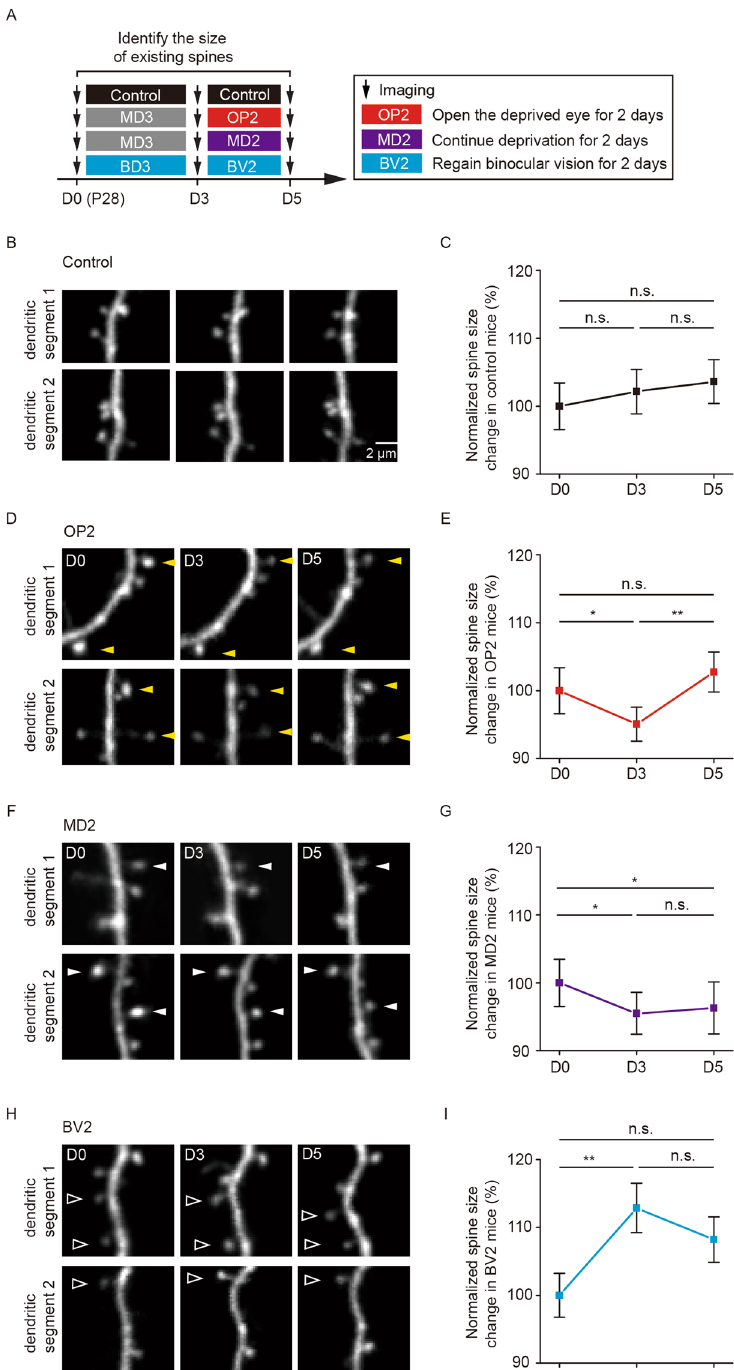
Figure 4. MD or BD-induced spine size changes tend to be reversed after binocular recovery. ( A ) Schematic of experimental design to evaluate the effect of visual deprivation and subsequent recovery on the size of dendritic spines in the binocular region of the primary visual cortex. ( B ) Images of dendritic spine size changes from day 0 to 5 in non-deprived control mice. Scale bar: 2 μ m. ( C ) Average spine size (measured by spine fluorescence relative to shaft fluorescence) exhibited no significant difference over 5 days in control mice (n = 116 spines from 6 mice). ( D ) Images of dendritic spine size changes from day 0 to 5 in OP2 mice. Yellow arrowheads indicate spines with size decrease after MD and size increase after subsequent binocular recovery. ( E ) Average spine size decreased during 3 days of MD and increased after 2 days of binocular recovery in OP2 mice (n = 145 spines from 5 mice). ( F ) Images of dendritic spine size changes from day 0 to 5 in MD2 mice. White arrowheads indicate spines with size decrease after MD and subsequent binocular recovery. ( G ) Average spine size showed no increase in mice with continued MD for additional 2 days (n = 125 spines from 5 mice). ( H ) Images of dendritic spine size changes from day 0 to 5 in BV2 mice. Open arrowheads indicate spines with size